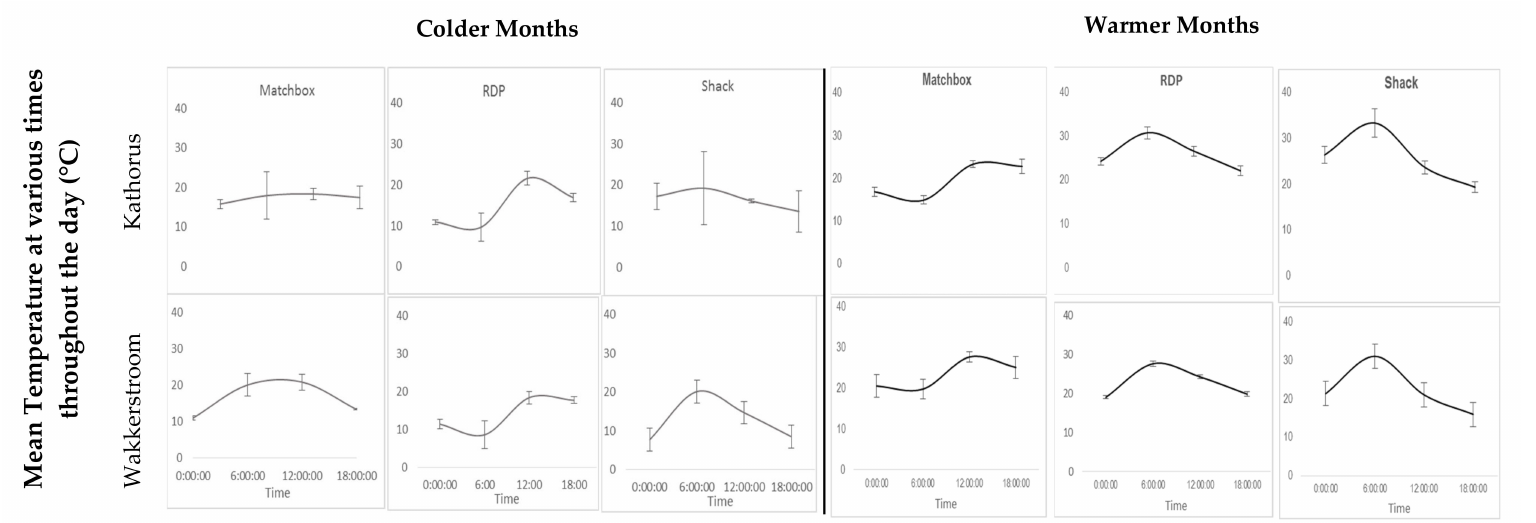
Figure 9. Mean indoor temperature readings at selected time throughout the day of the three housing types, during colder and warmer months in the Kathorus (top row) and Wakkerstroom areas (bottom row), error bars indicate daily mean temperature variance (n =